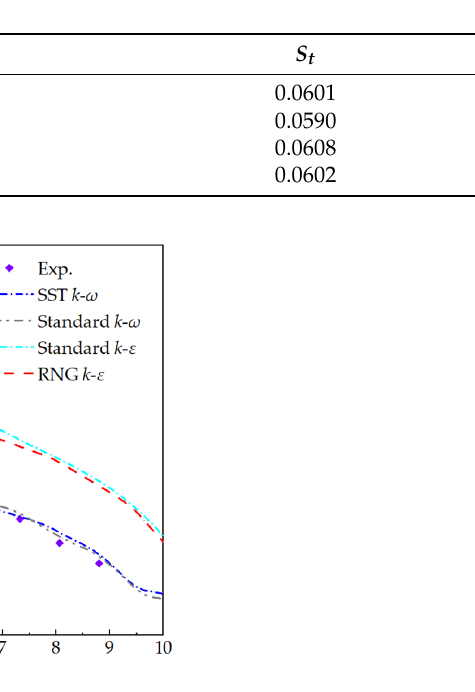
Figure 3. Heat transfer comparison between experimental data [27] and different turbulence models for sweeping jet at Re = 35,000, H/D = 6.